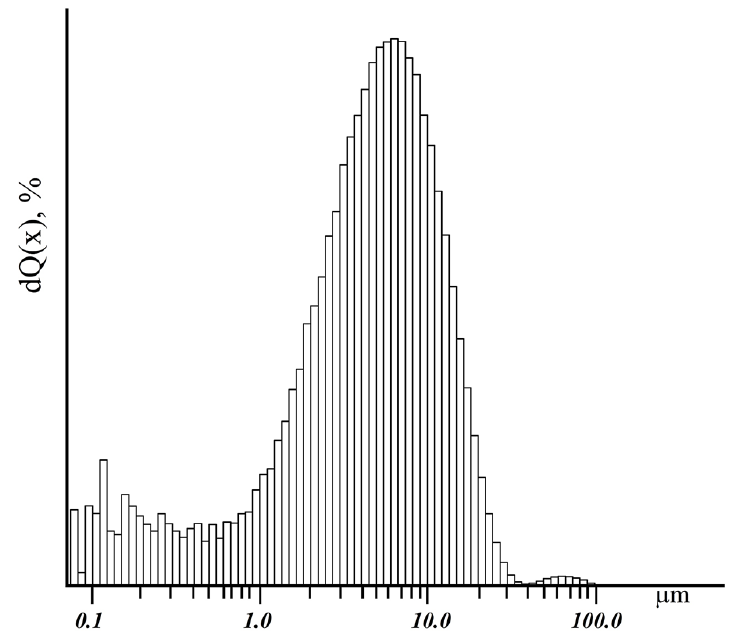
Figure 5. Particle size distribution of commercial tricalcium phosphate (Sigma-Aldrich).